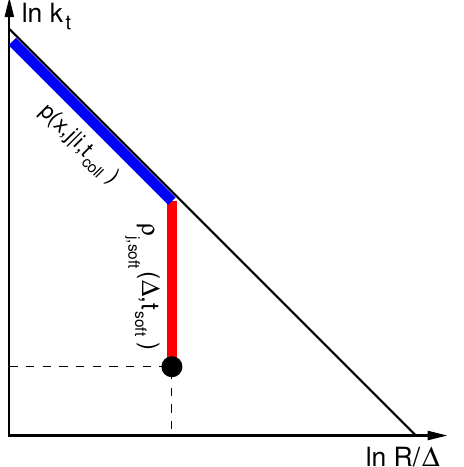
Figure 5. Schematic representation of eq. (3.39) where the density at a point ((cid:1) ; k t ) in the Lund plane is obtained by (cid:12)rst resumming collinear e(cid:11)ects at angles larger than (cid:1) and then soft gluons (at commensurate angles) down to a scale k t